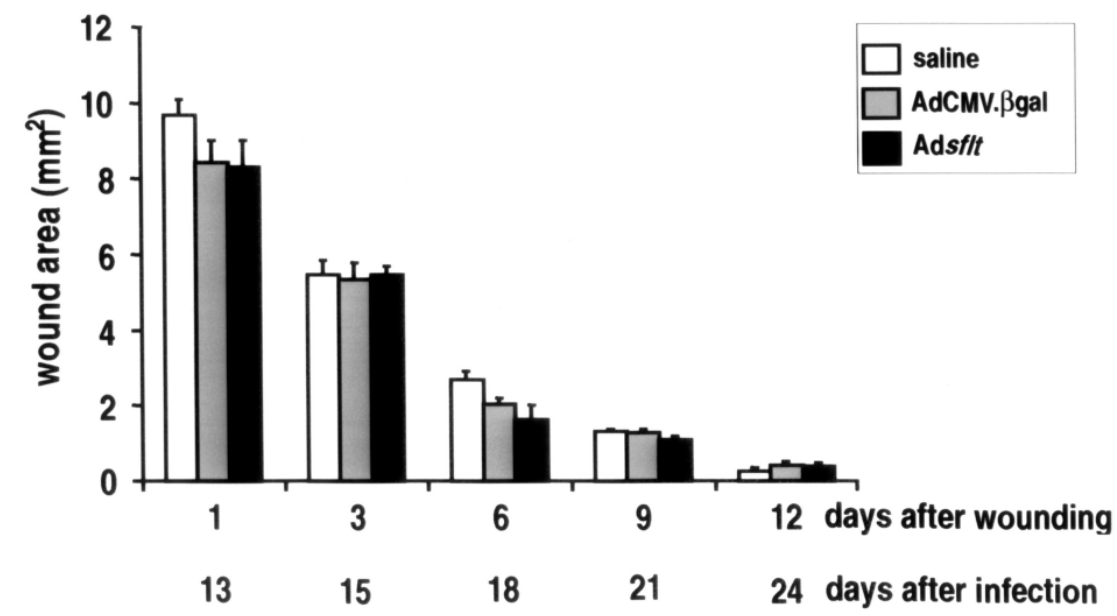
Figure 7. Ad sflt intratumor injection does not interfere with physiologic neoangiogenesis occurring during wound repair. Comparison of wound closure rates in nude mice injected intratumorally with saline, AdCMV. β gal or Ad sflt . One full-thickness skin excision was made on the upper dorsum of each female adult mouse and left undressed. At the indicated time points, wound areas were measured. Graph shows mean wound area expressed as mm 2 ± SE ( n = 6 mice per treatment group) ( p < 0.05).